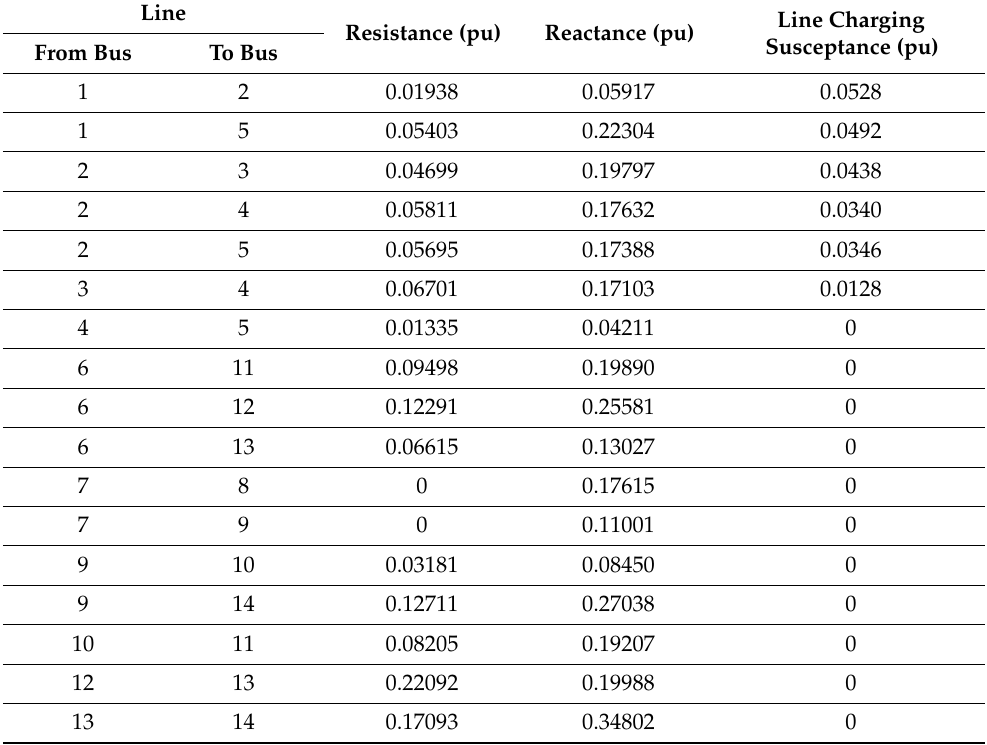
Table A1. Bus data for IEEE 14-bus